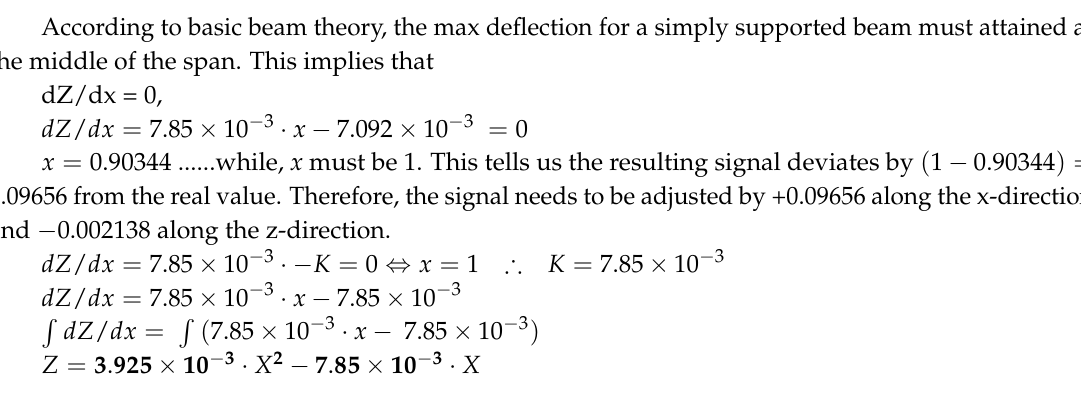
Figure 11. Genetic algorithm generation and individual values for a deflected shape.